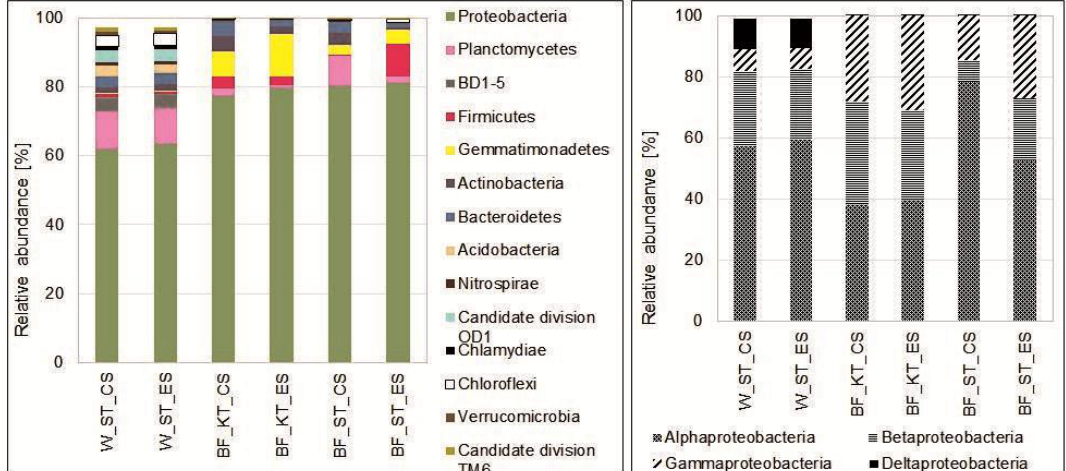
Figure 6. Left : Relative abundance of bacterial phyla. Right : Relative abundance of Proteobacteria classes in water from shower tap samples (W_ST) and biofilms (BF) sampled from kitchen (KT) and shower taps (ST) in conventional (CS) and extended system (ES).